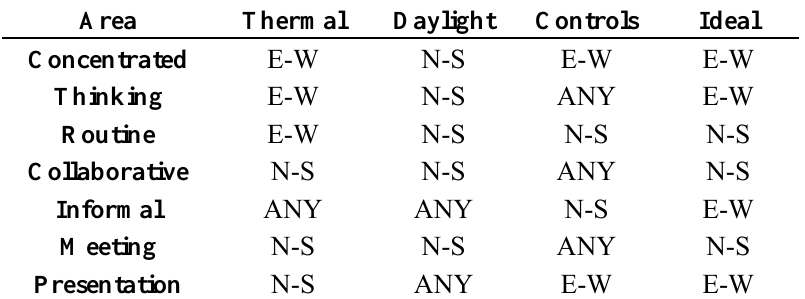
Figure 21. Summary of the findings from the analytical studies (thermal and daylighting simulations). Table 5. Recommended orientation for different working activities with the same floor plan of an office building in